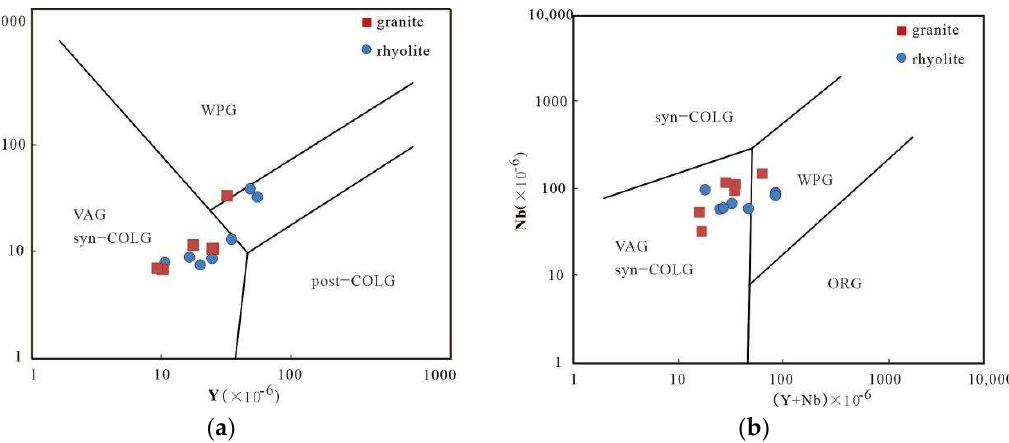
Figure 9. A structure diagram of the Early Cretaceous magmatic rock from the Badaguan area. ( a ): Nb−Y diagrams; ( b ): Nb−Y+Nb diagrams.